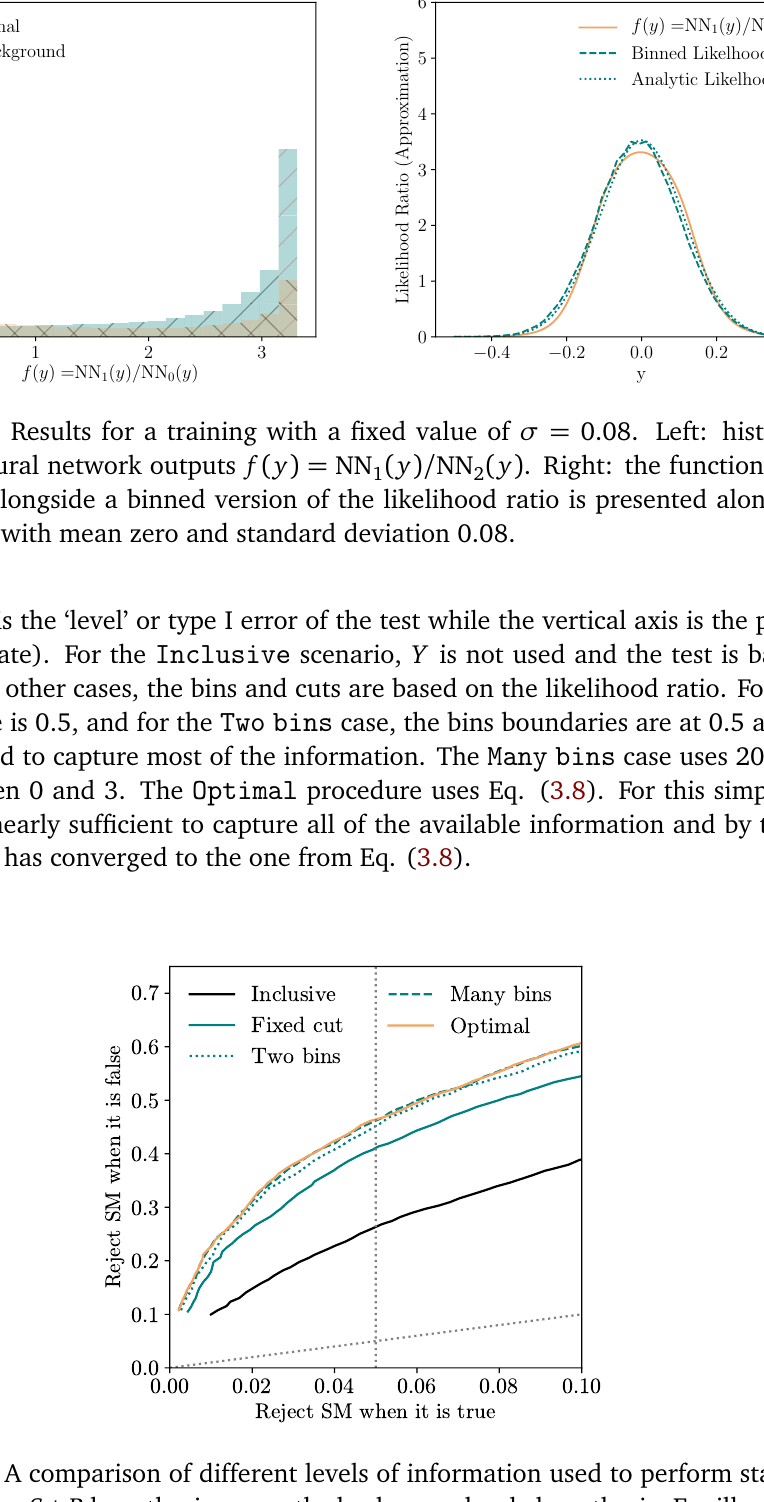
Figure 4: A comparison of different levels of information used to perform statistical tests for the S + B hypothesis versus the background-only hypothesis. For illustration, a type I error of 0.05 is shown as a vertical dotted line and another line with random guessing at power = type I error is also shown as a dotted line. All of the p -values are computed with 10 4